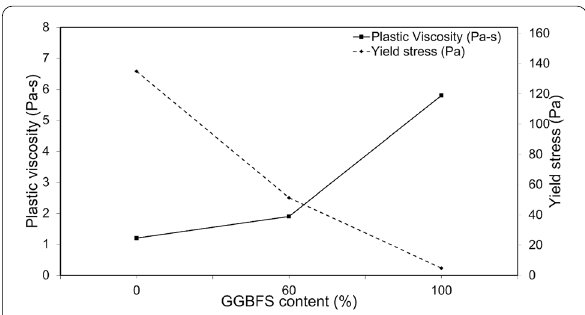
Fig. 10 Plastic viscosity and the yield stress of the binders.